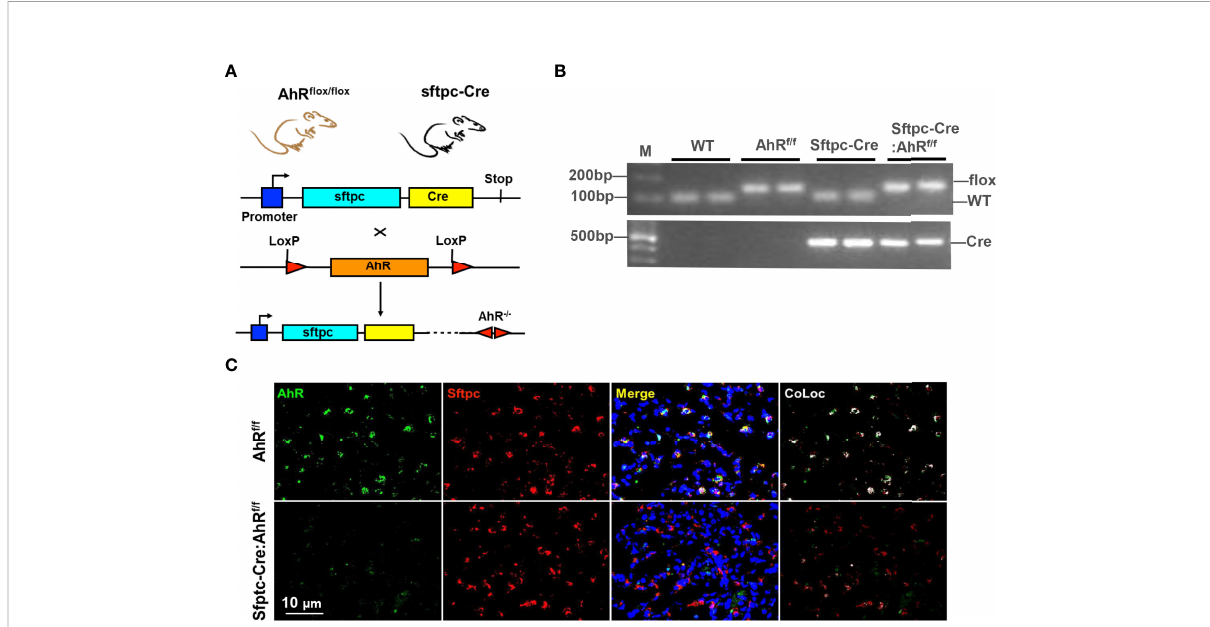
FIGURE 1 Generation of type II alveolar epithelial cell – speci fi c AhR knockout mice. (A) Schematic representation of the crossbreeding of a fl oxed AhR mouse ( AhR f/f ) with a Sftpc-cre mouse. (B) Con fi rmation of Sftpc-cre: AhR f/f mice by genotyping. (C) AhR deletion in AT2 cells of Sftpc-cre: AhR f/f mice was con fi rmed by co-immunostaining with Sftpc and AhR in the lung